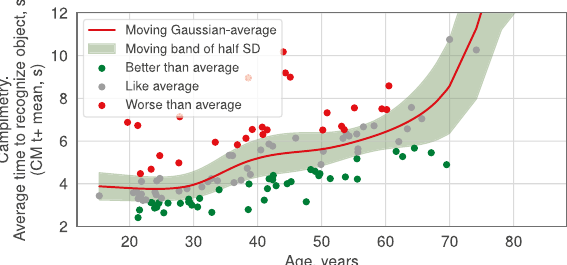
Fig. 1 Example of moving Gaussian-weighted average and corresponding moving standard deviation (SD) of cognitive quanti fi er over age. Subjects were marked as “ better performance ” (green point) — faster than average by SD, “ worse performance ” (red point) — slower than average by SD, and “ average performance ” (gray